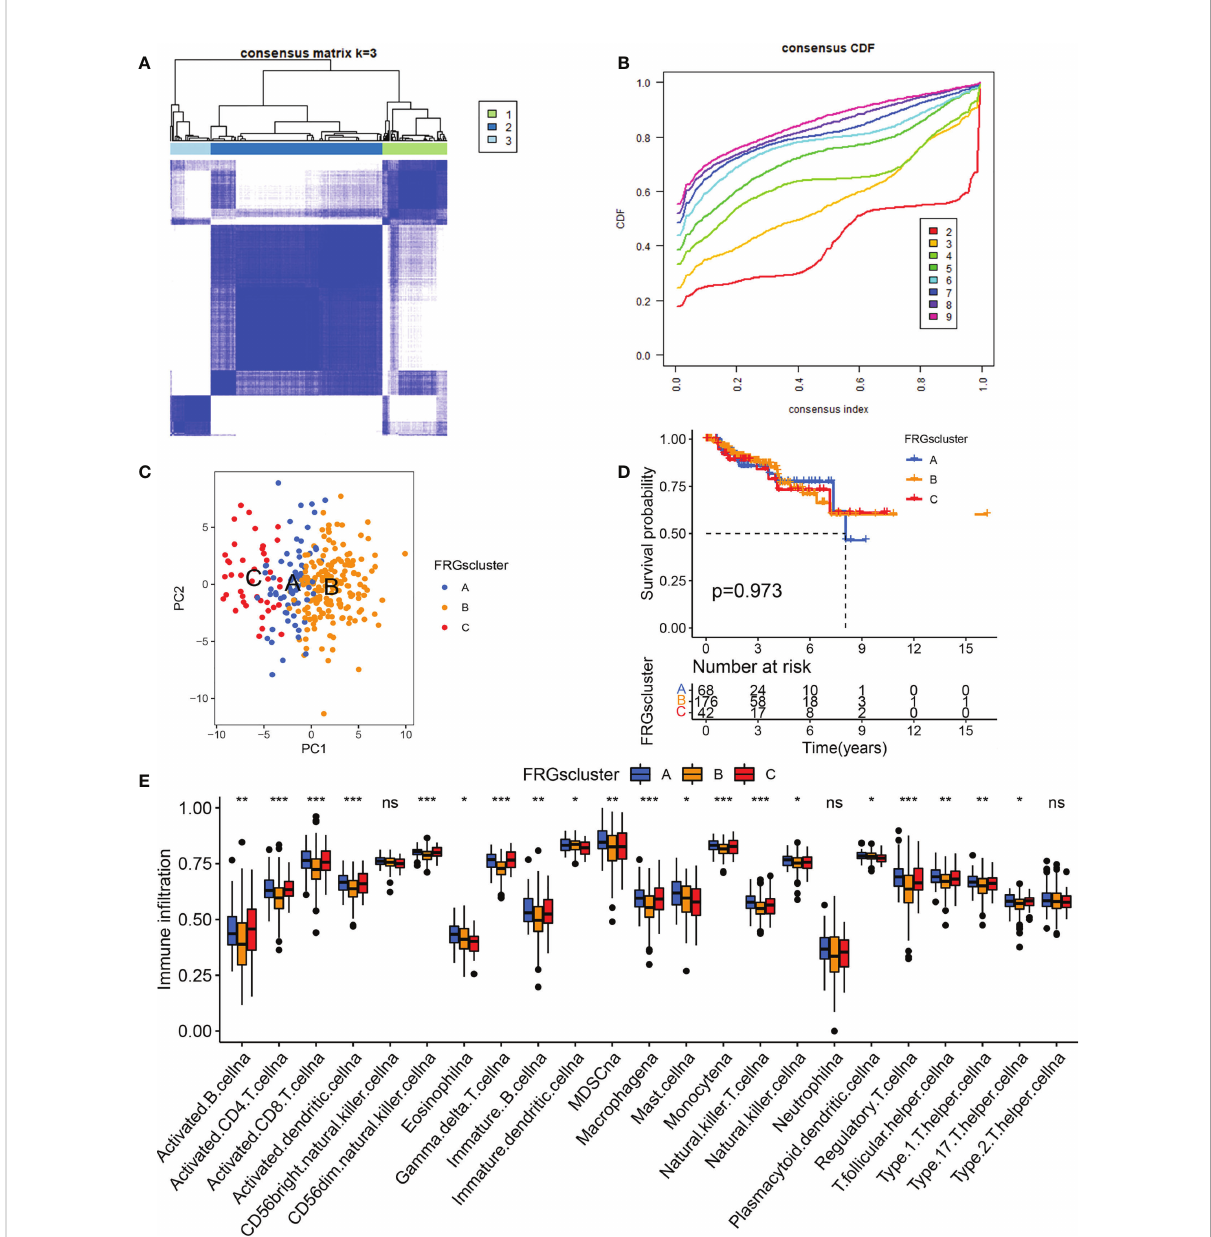
FIGURE 2 Tumor classi fi cation based on the differentially-expressed FRGs. (A) The consensus score matrix of all samples when k = 3 in TCGA cohorts. (B) Area under the curve for k = 2 – 9. (C) Principal coordinate analysis of three KIRP clusters. (D) Survival analysis of the KIRP subgroups comprising patients in the TCGA dataset. (E) The expression analysis of 23 immune cells in different KIRP subgroups * p < 0.05; ** p < 0.01; *** p < 0.001; n.s., not signi fi